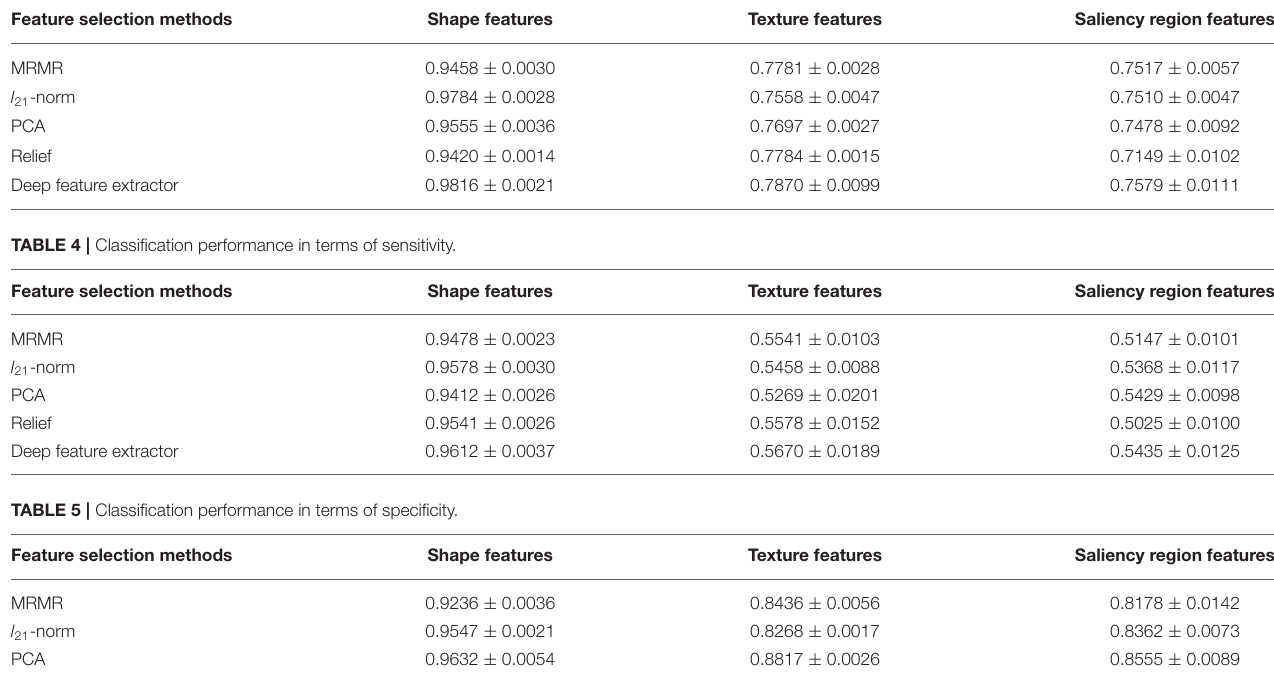
TABLE 3 | Classification performance in terms of accuracy.